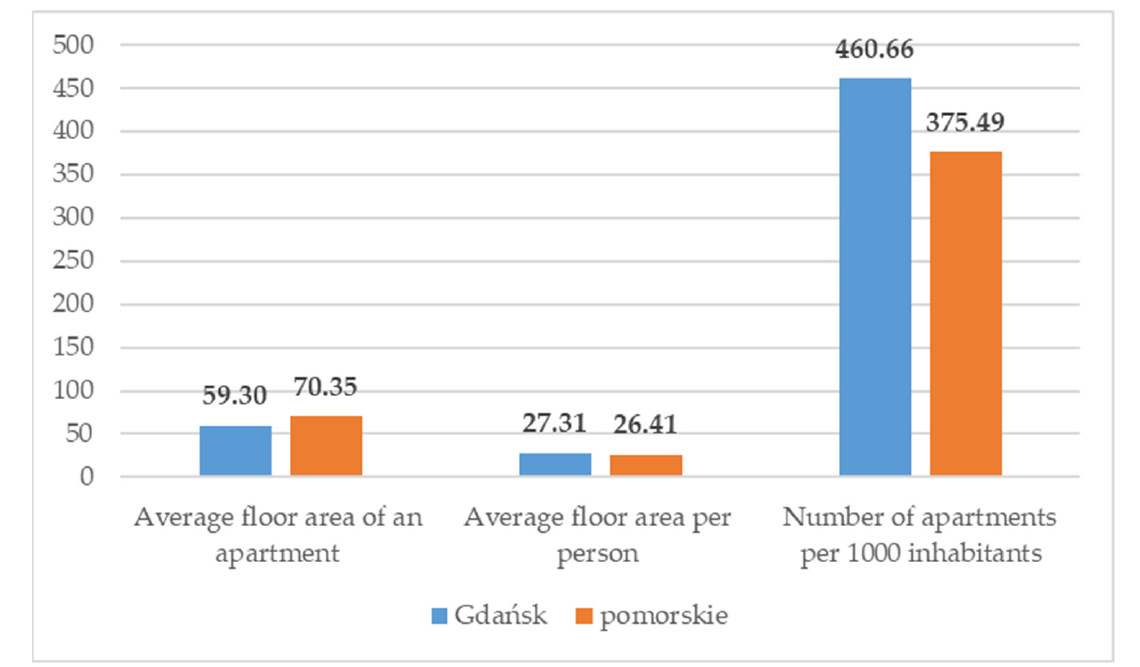
Figure 4. Indicators of housing infrastructure availability in Gda ń sk and the Pomeranian Province.